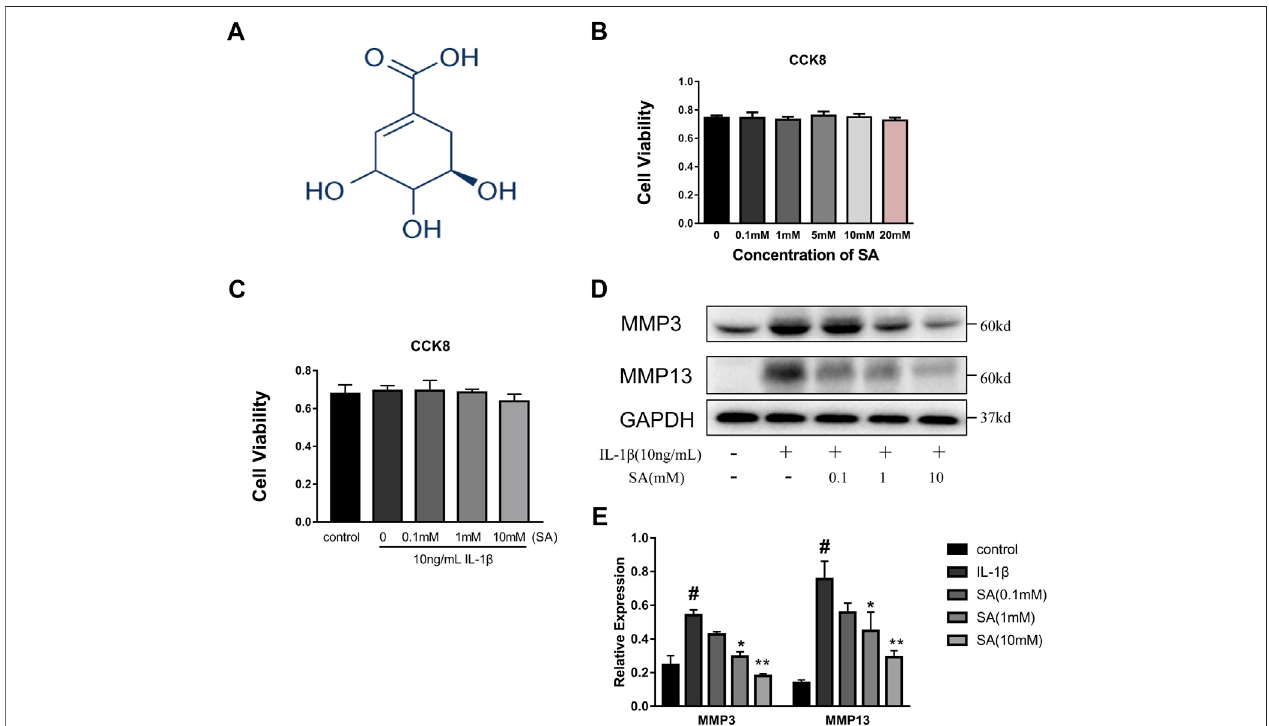
FIGURE 1 | SA has no impaired effect on cellular viability and 10 mM concentration is utilized in subsequent experiments. (A) Chemical structure of SA; (B) SW1353 cells were exposed to increasing concentrations ofSA (0, 0.1, 1, 5, 10, and 20 mM), and cell viability was determined by CCK-8 assay. The data are shown as themean ± SD( n (cid:2) 5); (C) SW1353cellswereexposedto10 ng/mlwithorwithoutSA,andcellviabilitywasdeterminedbytheCCK-8assay.Thedataareshown asthe mean ± SD( n (cid:2) 5). (D,E) Representativewesternblotsandquanti fi cationdatashowingtheMMP3andMMP13expressionintheSW1353cellsofeachgroup.The dataareshownasthemean ± SD( n (cid:2) 3).Signi fi cantdifferencesbetweengroupsareindicatedasfollows: # p < 0.05vs.thecontrolgroup;* p < 0.05and** p < 0.01vs.the IL-1 β